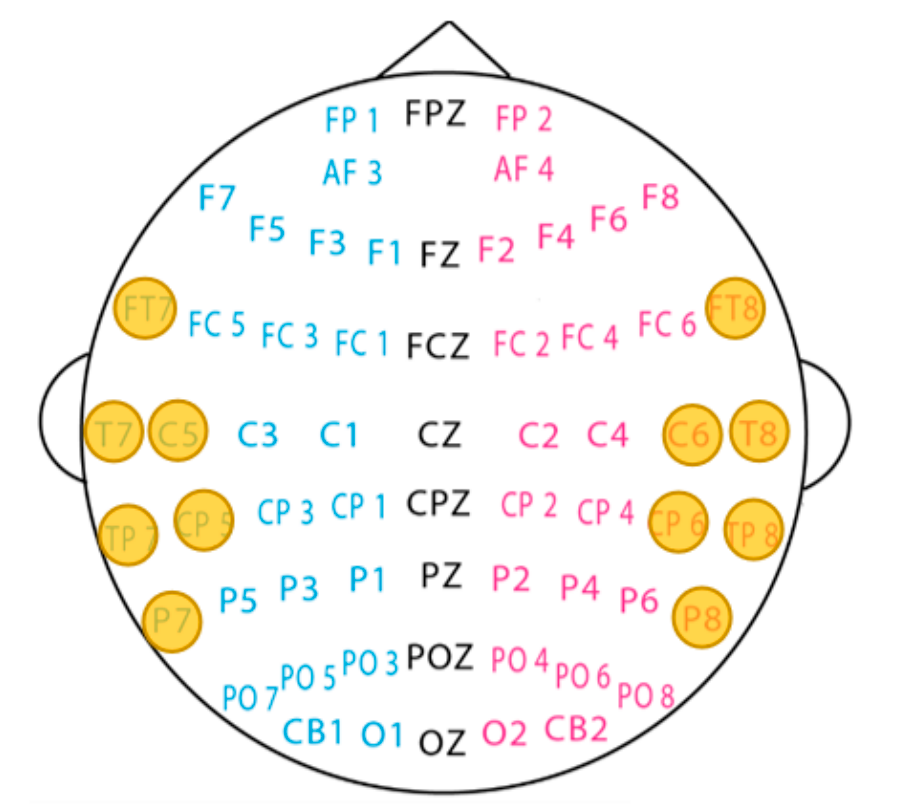
Figure 4. Channel selection (the proposed 12 channels are marked with yellow circles).